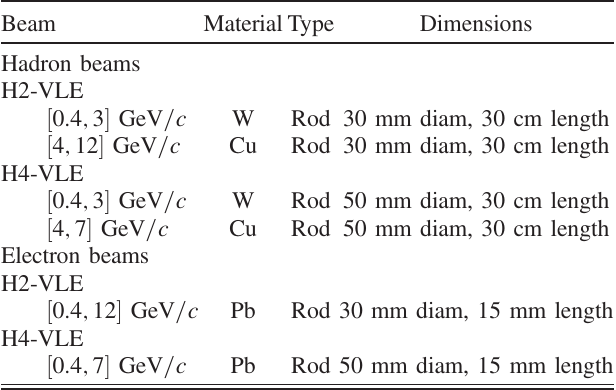
TABLE II. Parameters of the secondary targets. Beam Material